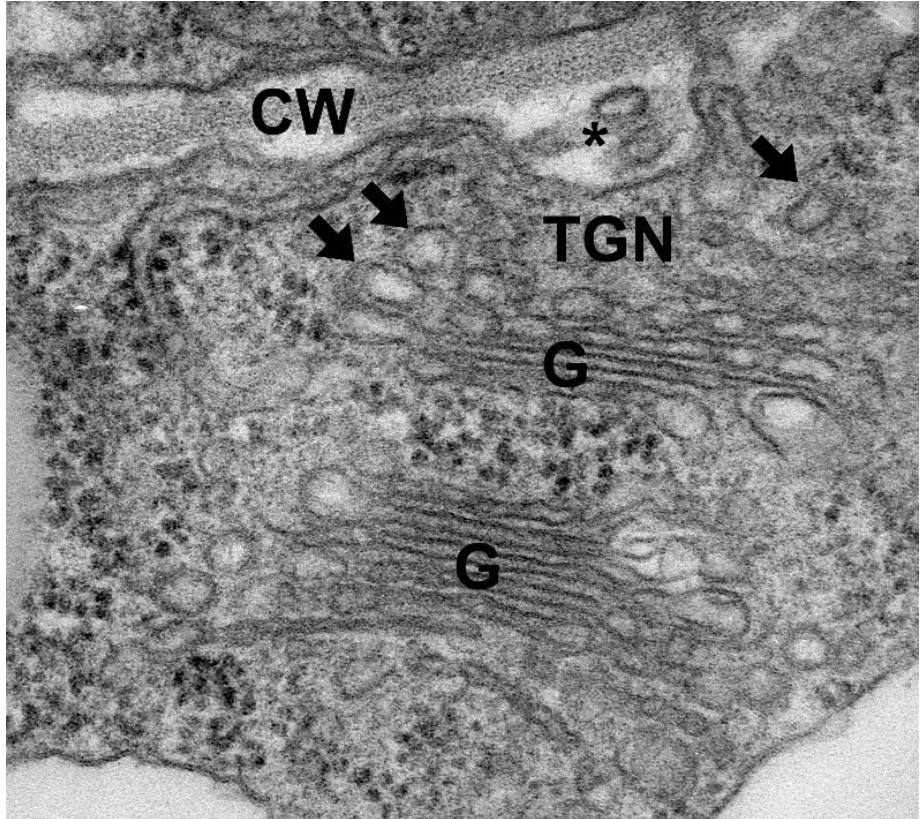
Figure 2. Cellular trafficking of molecules by endomembrane system in plants. Two Golgi apparatus (G) are located close to each other, producing vesicles (arrows). Their cargo is delivered to cell wall (CW) via vesicles (asterisk) through trans Golgi network (TGN).